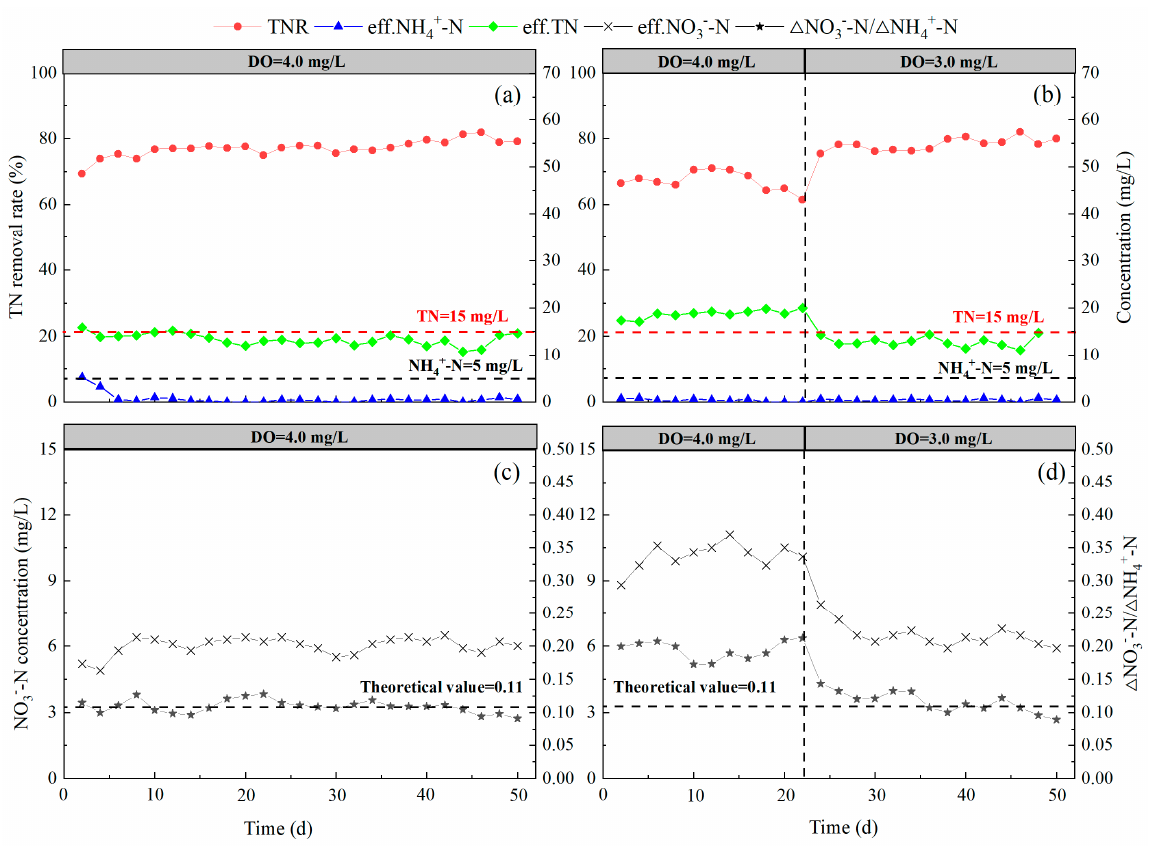
Figure 3. The effect of DO on the nitrogen removal performance of the A1 ( a , c ) and A2 ( b , d ) immobilized filler reactors.